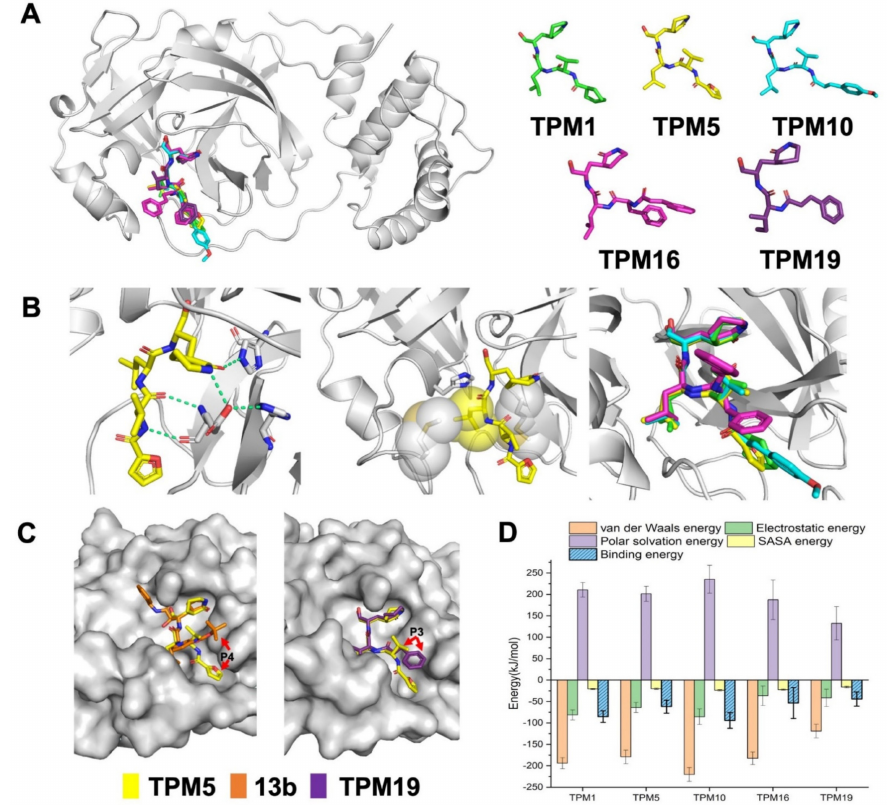
Figure 3. Crystal structures of the 3CL Pro –TPM complexes. ( A ) 3D representation of five TPMs and their overall binding modes. ( B ) The P1 δ -lactam ring formed polar interactions (green, dash line) with S1 residues (left), P2 isopropyl group stacked with S2 hydrophobic residues (middle), and the alignment of isopropyl groups from different TPMs (right). ( C ) The P3/P4 group of TPM5 bound into the S3/S4 groove in comparison to that of 13b or TPM19. ( D ) The binding energies between 3CL Pro and TPMs from all-atom simulations.